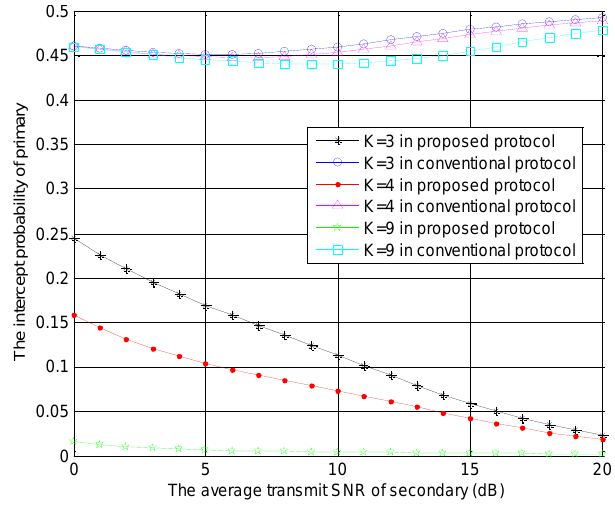
Figure 4. The intercept probabilities of primary users versus r 2 with different K